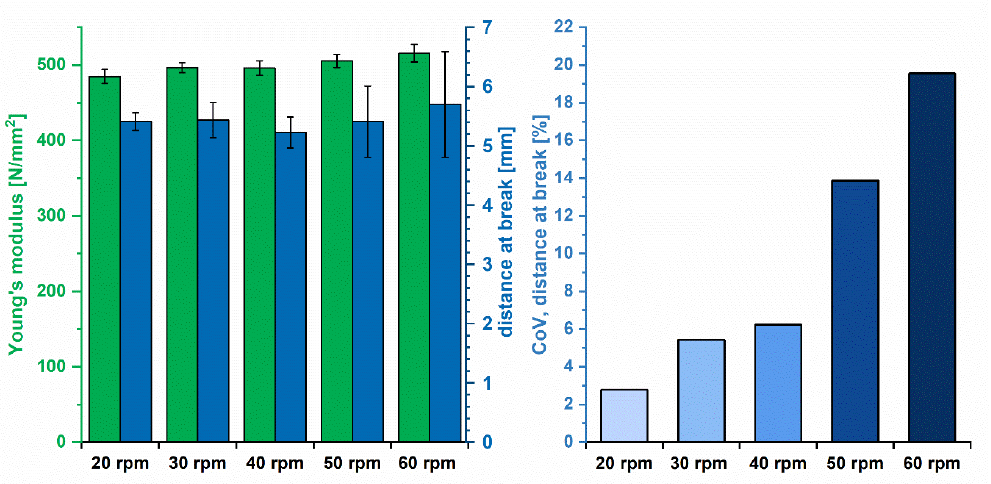
Figure 8. Determined YM and distance at break of filaments produced at different screw speeds (mean ± CI, n = 6 (α = 0.05), left) and the CoV distance at break related to the applied screw speed (right).